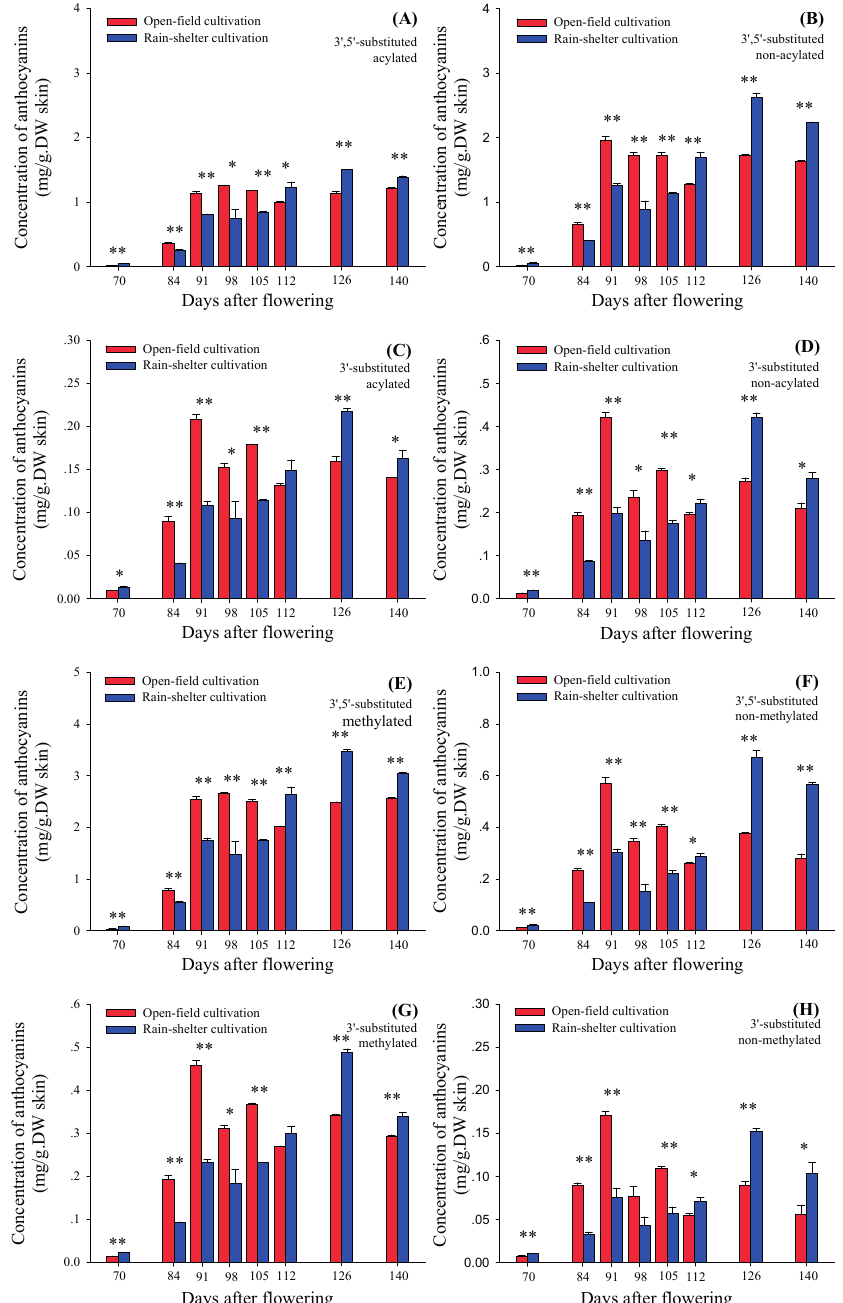
Figure 5. The variation in the concentrations of different kinds of anthocyanins in berry skins of vines grown under open-field cultivation and rain-shelter cultivation during berry maturation. These compounds are divided into acylated ( A ) and non-acylated ( B ) anthocyanins from F3'5'H branch (3',5'-substituted) as well as acylated ( C ) and non-acylated ( D ) anthocyanin from F3'H branch (3'-substituted). Another classification is made according to methylation in 3'- or 3',5'-position(s) of ( E ) and non-methylation ( F ) anthocyanins from F3'5'H branch, as well as methylation in 3'-position of ( G ) and non-methylation ( H ) anthocyanins from F3'H branch, respectively. Data are mean ± standard deviation. The symbol “**” or “*” above each set of columns represents that there are significant differences between rain-shelter cultivation and open-field cultivation by Duncun analysis at 0.01 level ( p < 0.01) or 0.05 level ( p < 0.05). n =